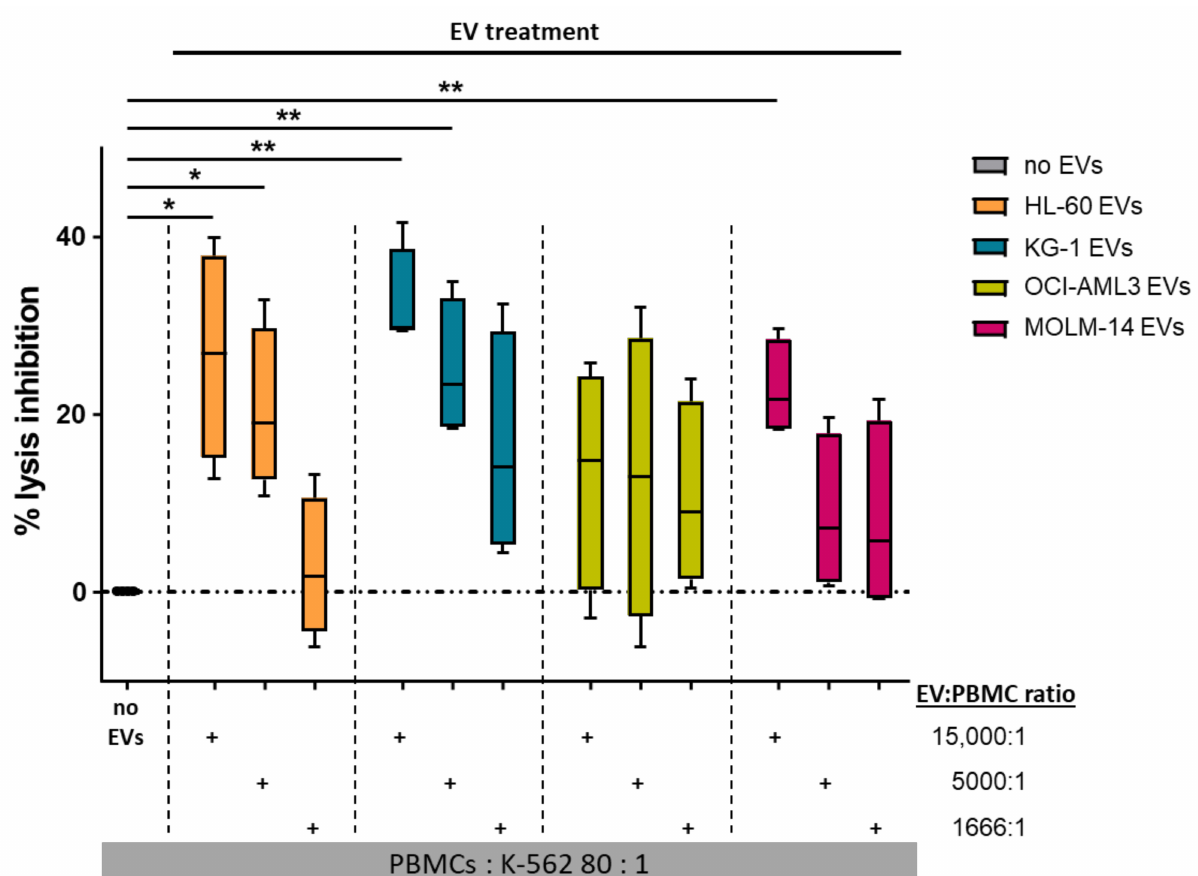
Figure 5. AML-EVs inhibit NK-mediated cytotoxicity. PBMCs were treated with different doses of AML-EVs before analysis of their capacity to lyse K-562 leukemia target cells. Treatment with graded doses of purified EVs from all four AML cell lines as color-coded in the legend. Abbreviations: EVs, extracellular vesicles; PBMCs, peripheral blood mononuclear cells from healthy donors. Paired Student’s t -test, * p < 0.05, ** p < 0.01; n =